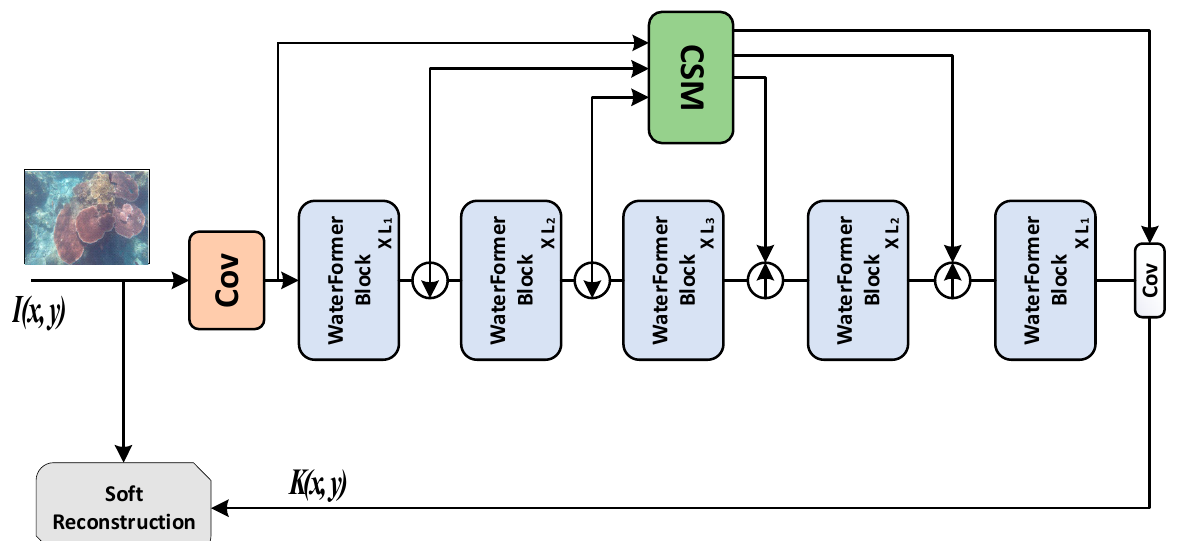
Figure 2. The overall structure of SRN.